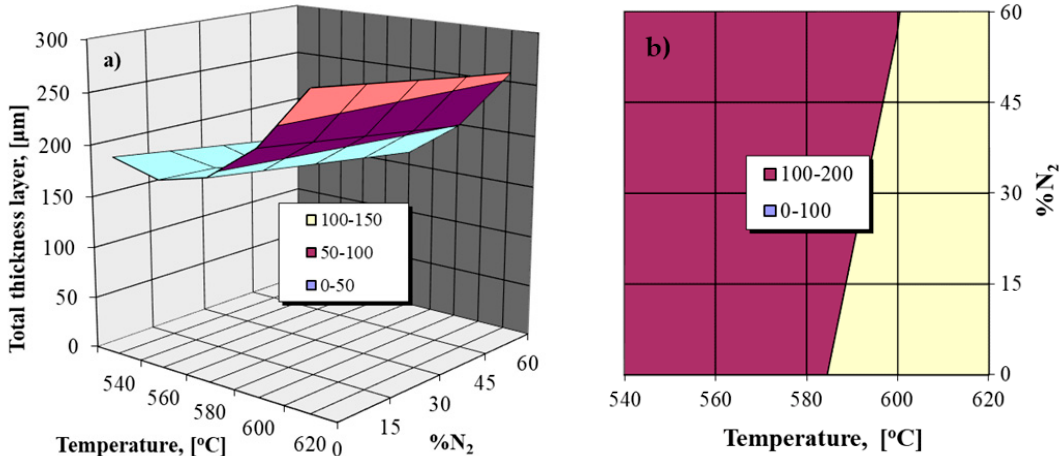
Figure 6 Figure 6. The dependence of the total thickness of the nitrided layer on the nitriding temperature and the nitrogen proportion in the NH 3 +N 2 gaseous mixture for the 34CrAlMo5 nitralloy steel; 4 h holding time; ( a ) the response area of the regression Equation (21); ( b ) iso-properties